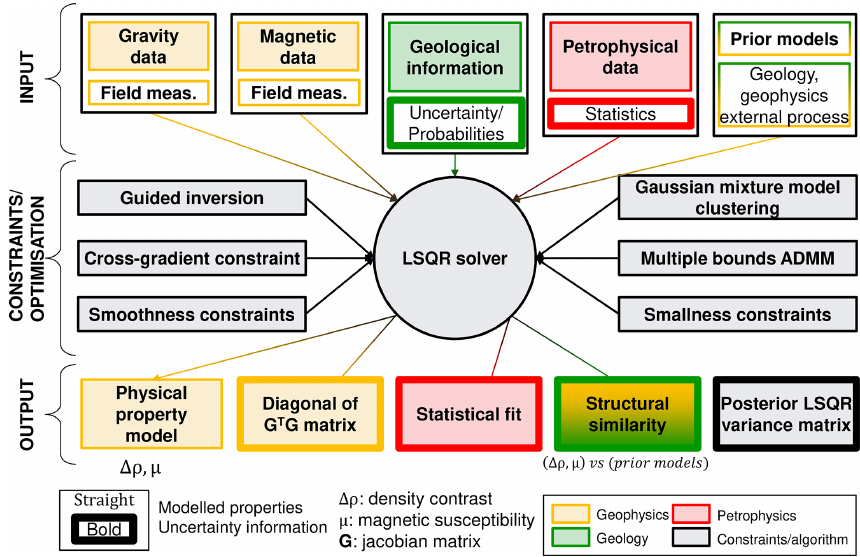
Figure 1. Modelling workflow summary (modified from Jérémie Giraud, Loop Workshop, March